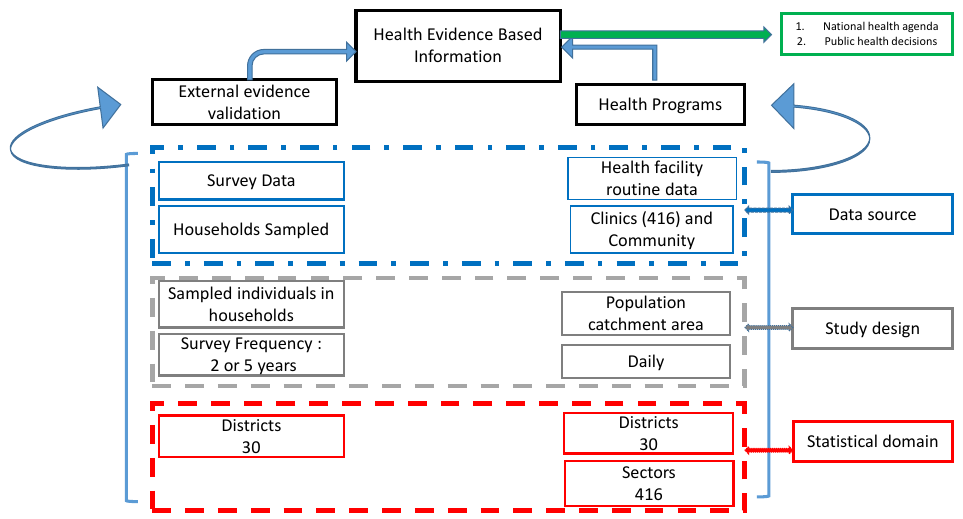
Figure 2. Data sources to inform evidence-based decision in